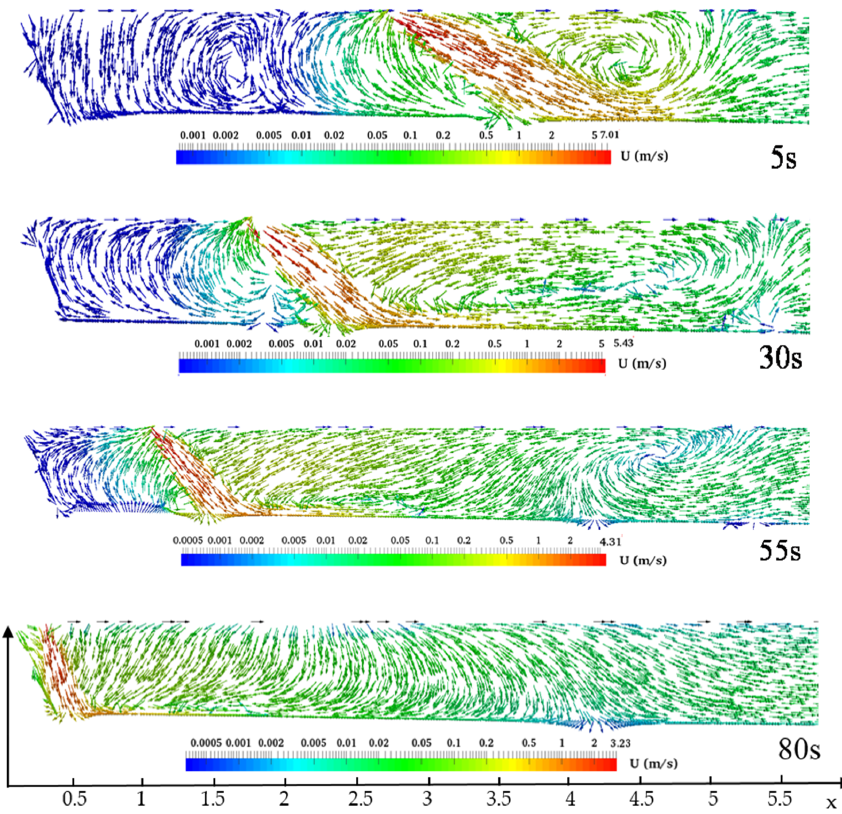
Figure 5. Velocity distribution on the center plane (cf. Figure 3a) at 5, 30, 55 and 80 s.